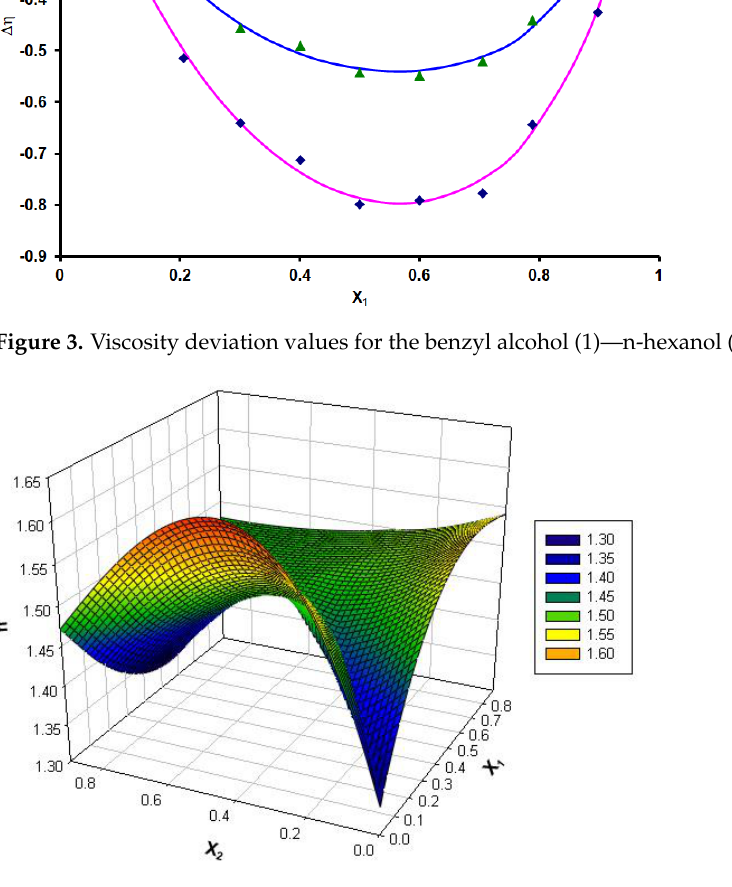
Figure 4. Variation of refractive index with mole fractions at different temperatures.